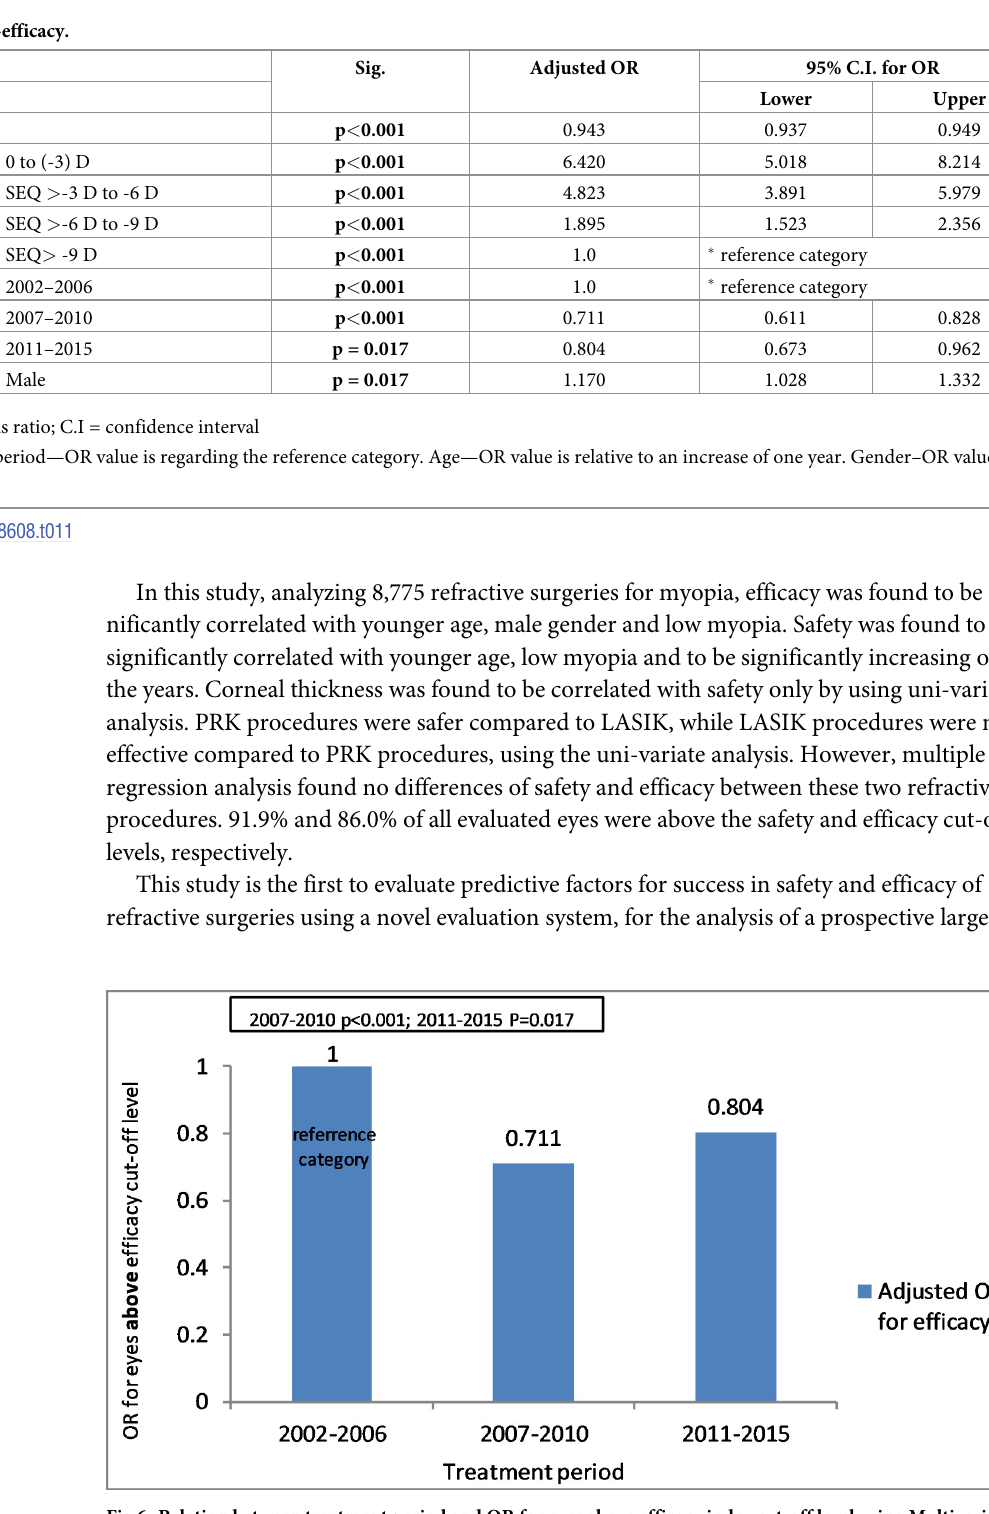
Fig 6. Relation between treatment period and OR for eyes above efficacy index cut-off level using Multivariate analysis and Logistic regression model (p < 0.001 for 2007–2010 period; P = 0.017 for 2011–2015 period). OR value is regarding the reference